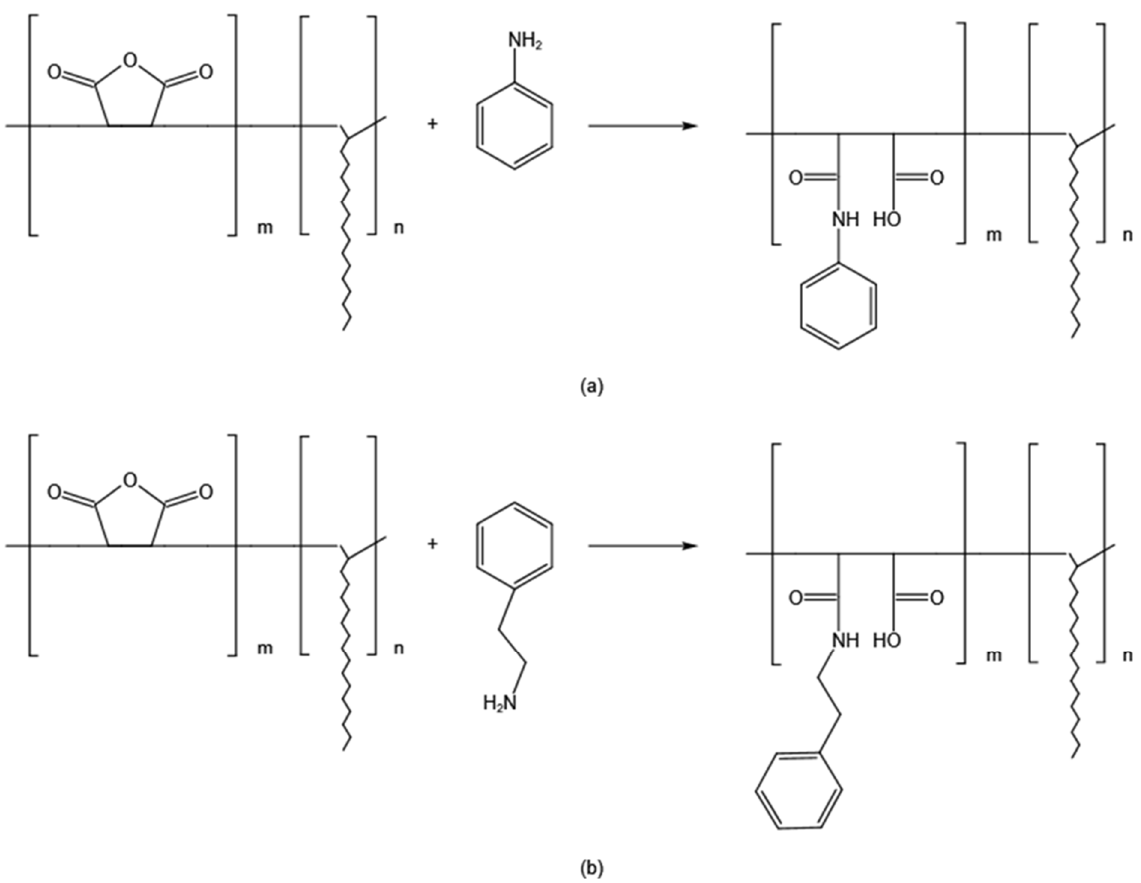
Figure 3. Synthesis of AMAC and EMAC: ( a ) synthesis of AMAC; ( b ) synthesis of EMAC.